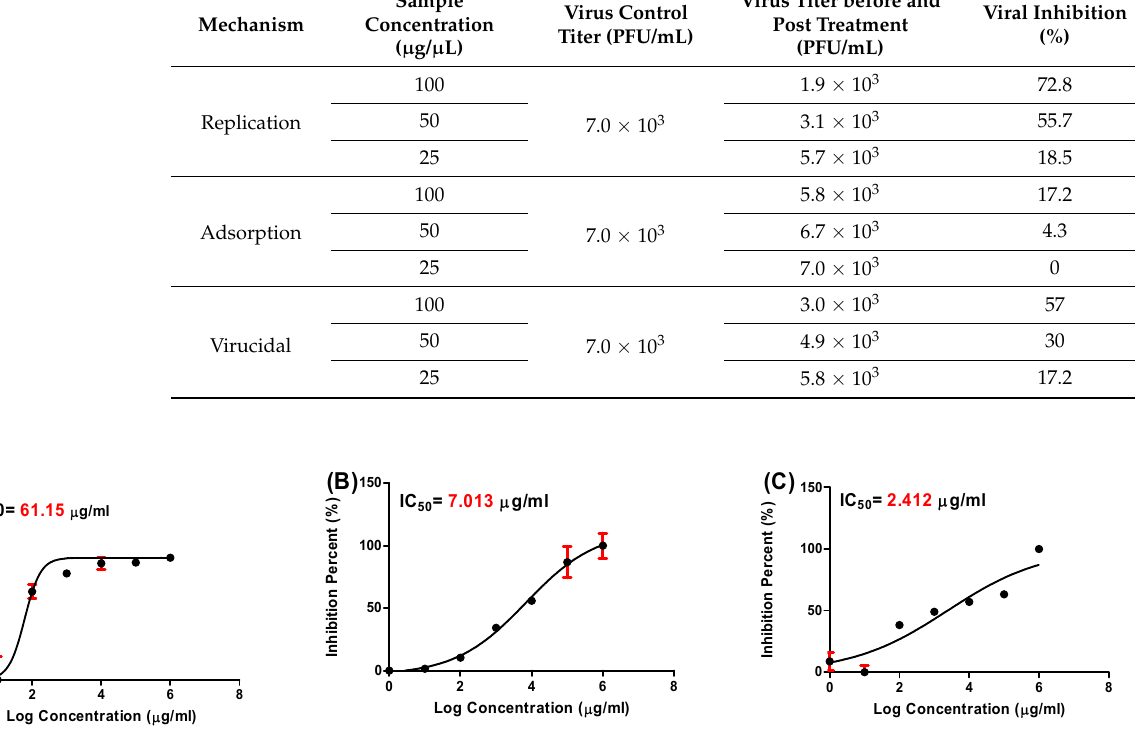
Table 4. Mode of action of antiviral activity.